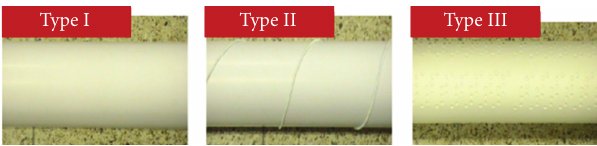
Figure 27: Three types of cables for lab tests: regular cable (type I), cable wound with a spiral wire (type II), and dimpled cable (type III)